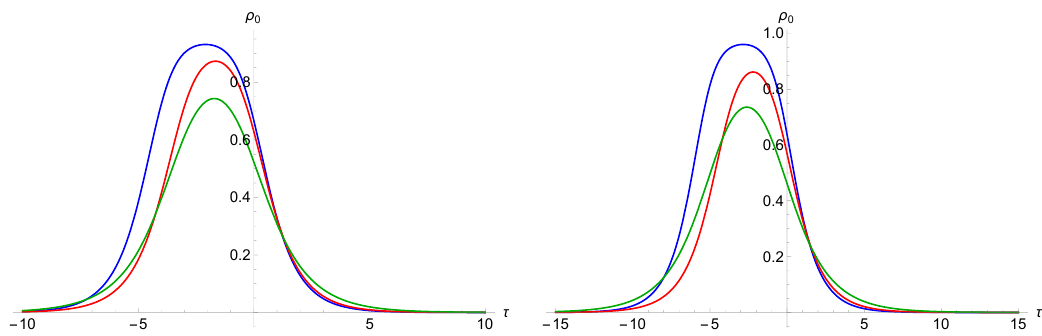
Figure 3 . Plots of the instanton solution as a function of the euclidean time from equation (3.8). In terms of the potential that is depicted in figure 1, the instanton transition is from the point graviton extremum at τ → −∞ to a position of the potential with the same energy as the point graviton at an intermediate time (where the maximum of the curve is located) and then back to the initial point graviton extremum at τ → + ∞ . On the left plot the conjugate momentum is fixed to the value J = 0 . 9 and the three curves correspond to different values of the deformation 1 parameter: Blue ⇒ ∆ = 0 . 1 , Red ⇒ ∆ = 0 . 3 & Green ⇒ ∆ = 0 . 5 . On the right plot the conjugate momentum is fixed to the value J = 1 . 05 and the three curves correspond to different values of 1 the deformation parameter: Blue ⇒ ∆ = 0 . 4 , Red ⇒ ∆ = 0 . 5 & Green ⇒ ∆ = 0 . 6 . Notice that in the right plot the values of the deformation parameter are always above the critical value so that the giant graviton has less energy than the point graviton. For J = 1 . 05 the critical value for the 1 deformation is ∆ 0 . 39 crit ≈